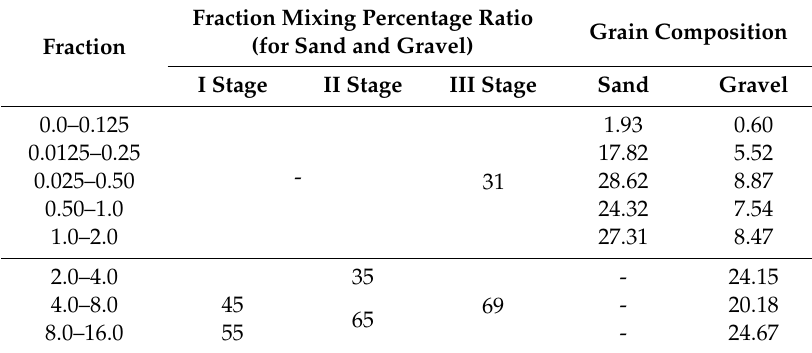
Table 1. Percentage contain of the aggregates selected by iterations.